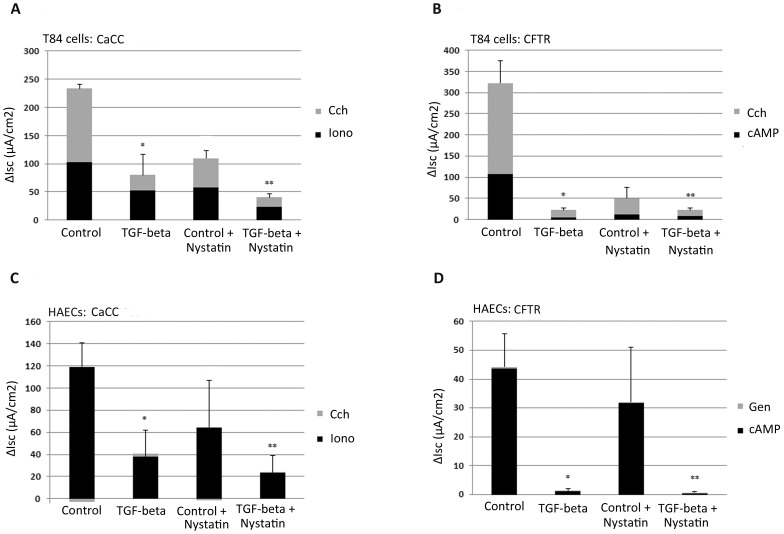
Downregulation of both CaCC and CFTR currents in T84 cells and HAECs by TGF-beta.T84 (A and B) and HAECs (C and D) were treated with TGF-beta (10 ng/ml) for 48 h prior to Isc measurement and studied as described in the Methods and as shown in Figure S1. T84 cells without nystatin were studied with symmetric apical and basolateral buffers. All other T84 and HAEC studies were completed with a basolateral-to-apical chloride secretory gradient [27]. Briefly, to activate CaCC-dependent chloride transport in T84 monolayers (A), cells were stimulated with ionomycin (Iono; 2 µM) to raise calcium and carbachol (CCh; 100 µM, basolateral) to activate basolateral potassium channels and drive apical chloride exit. Similar stimuli were used in HAECs (C) but carbachol had little effect on stimulated Isc. To activate CFTR-dependent chloride transport in both cell types (B and D), cells were stimulated with forskolin/IBMX (10 µM/100 µM) to raise cAMP. In T84 cells (B), carbachol (100 µM, basolateral) was used to increase apical chloride transport similar to A. In HAECs (D), genistein (50 µM, apical) was used to potentiate CFTR. The right two bars in each panel represent studies with a chloride secretory gradient following permeabilization of the basolateral membrane with nystatin (50 µg/ml). (A) *P = 0.001compared with control; **P = 0.007 compared with nystatin control. (B) *P = 0.003 compared with control; **P = 0.015 compared with nystatin control. (C) *P = 0.041 compared with control; **P = 0.016 compared with nystatin control. (D) *P = 0.006 compared with control; **P = 0.014 compared with nystatin control.